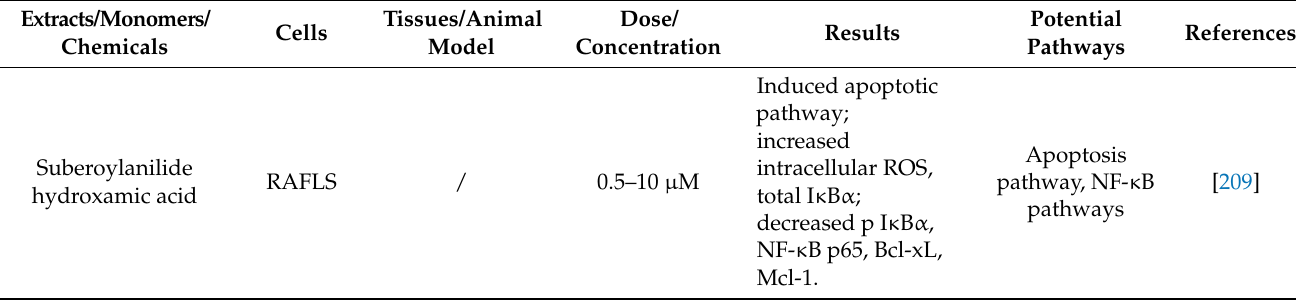
Table 2. Chemical components that induced the ROS level of RA-related cells to improve